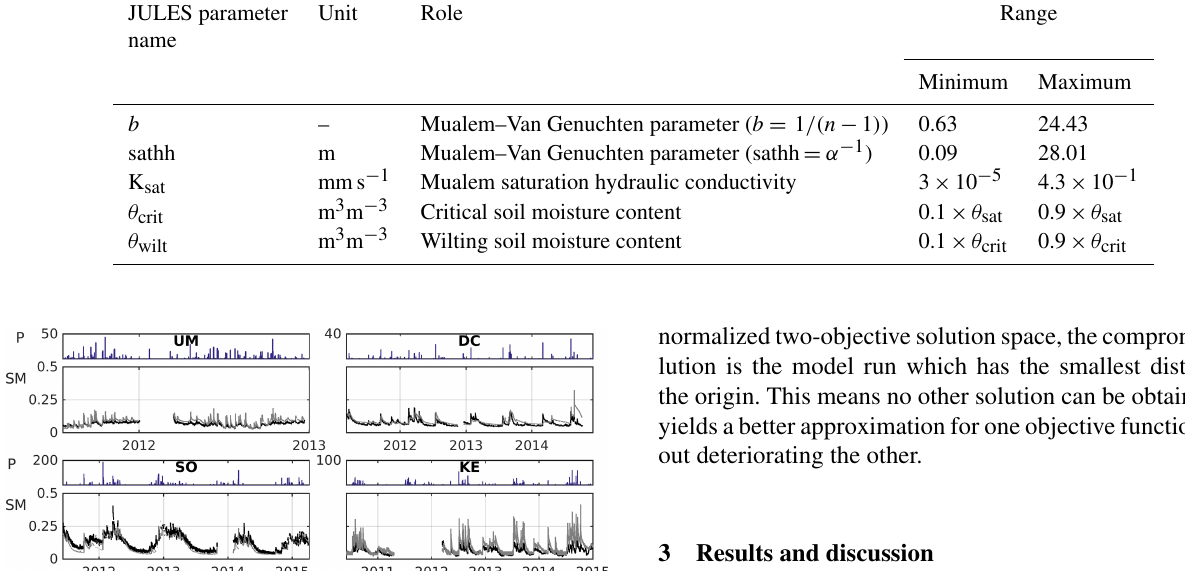
Table 2. Calibrated parameter definitions and calibration ranges. JULES parameter Unit